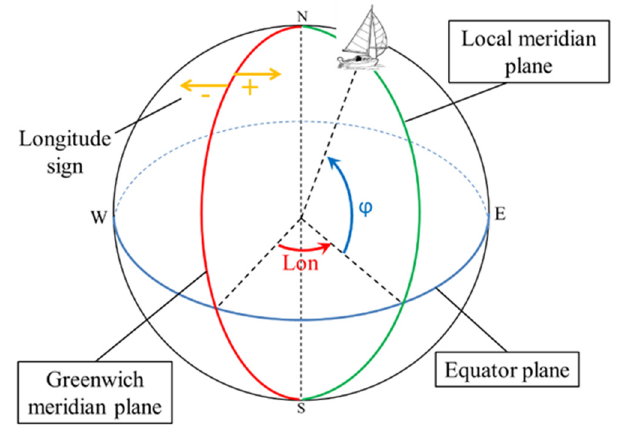
Figure 7. Localization of a point of the Earth: longitude (Lon) and latitude ( ϕ ).